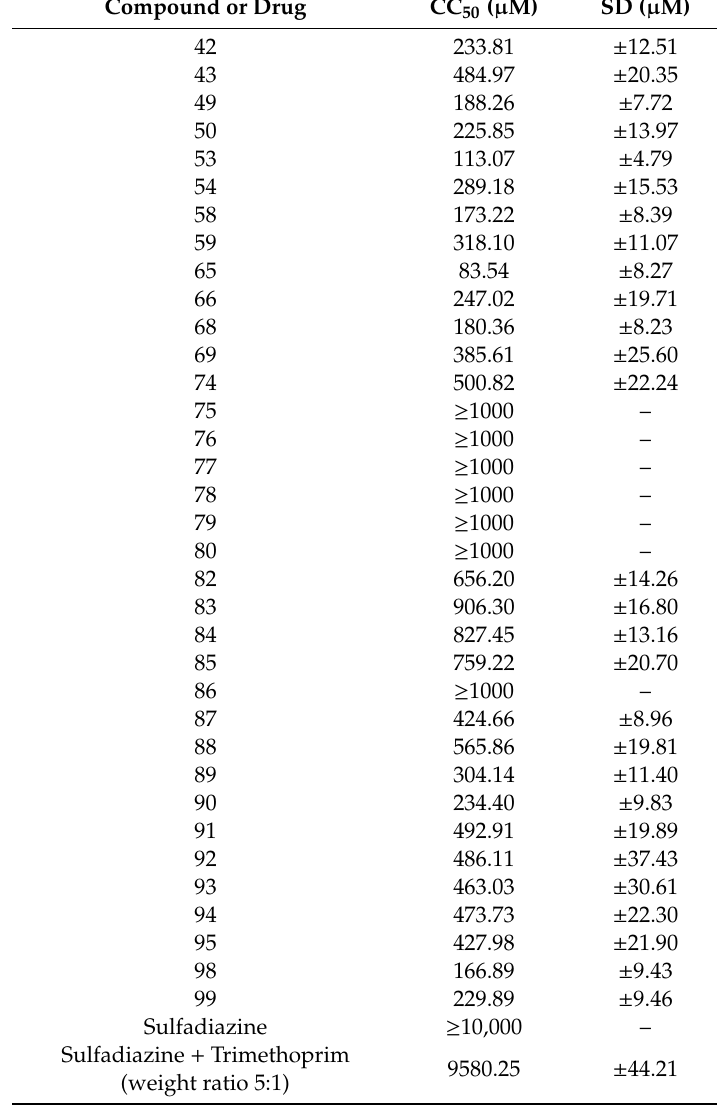
Table 1. Cytotoxicity of the thiazolidin-4-one derivatives ( 42 , 43 , 49 , 50 , 53 , 54 , 58 , 59 , 65 , 66 , 68 , and 69 ), (4-oxothiazolidin-5-ylo)acetic acid derivatives ( 74 – 88 ), (4-oxothiazolidin-5-ylidene)acetic acid derivatives ( 89 – 95 , 98 , and 99 ) and drugs against L929 cells; SD —standard